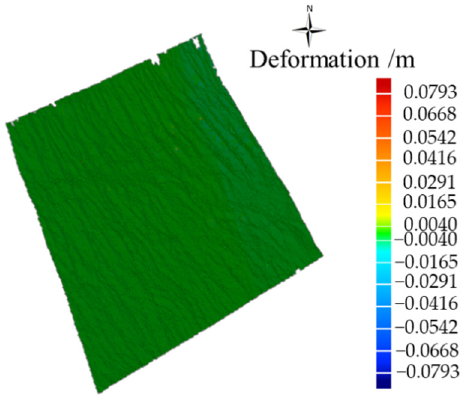
Figure 28. Deformation of Lihua landslide.